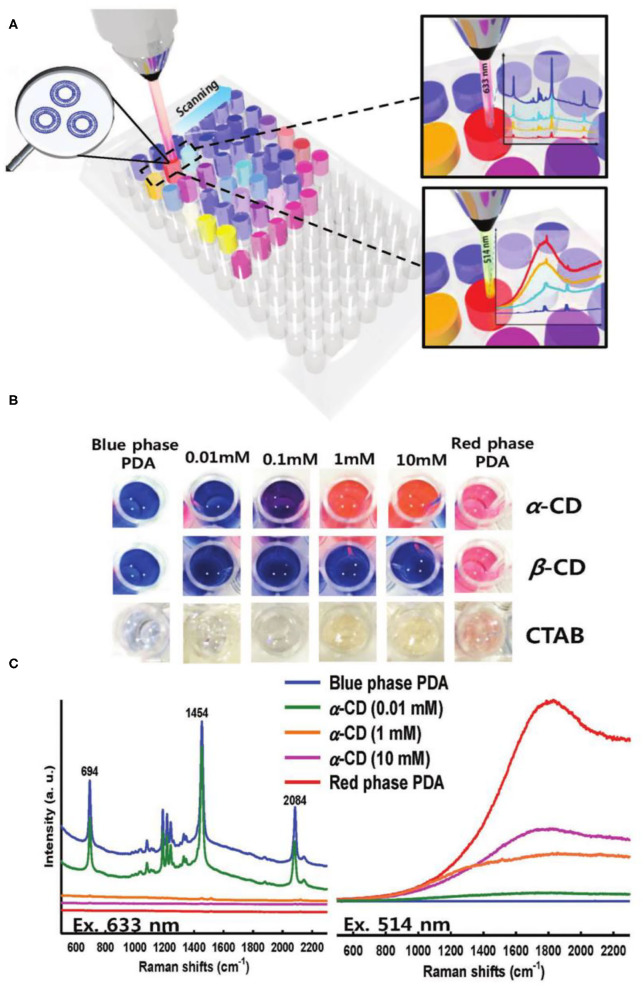
(A) A schematic representation of well-plate detection and (B) the corresponding optical images of PDA solutions upon exposure to α -, β -CD, and CTAB, respectively. (C) Raman spectra of PDA exposed to α –CD with laser excitation of 633 and 514 nm, respectively. Concentrations of the added CDs are indicated with lines of color. Reprinted with permission from Cui et al. (2018a). Copyright 2018, Wiley.